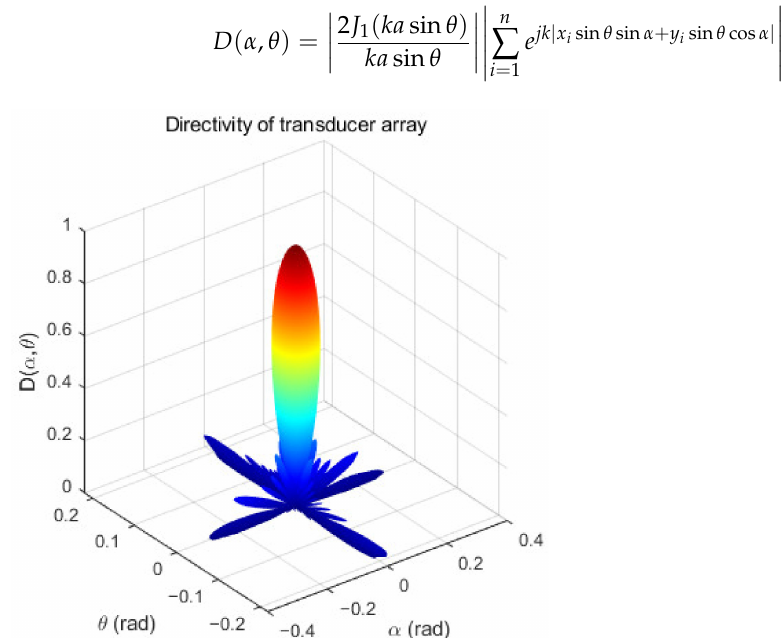
Figure 3. Transducer array directivity. The X-axis is angle α (rad), the Y-axis is angle θ (rad), and the Z-axis is directivity D ( α , θ )